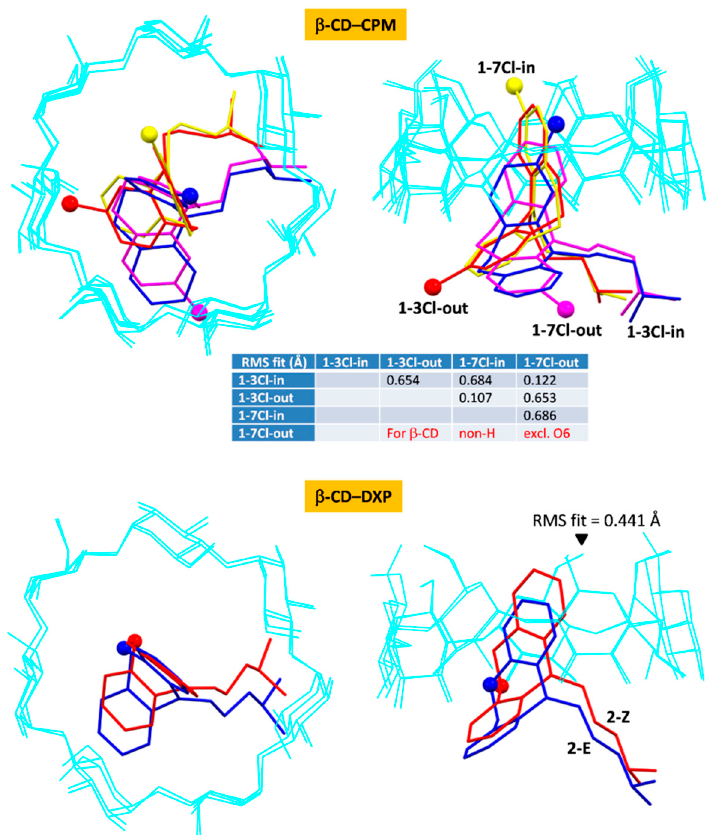
Figure 7. Superposition of molecular structures of β -CD–CPM (four modes) and β -CD–DXP (two modes) inclusion complexes from DFT full-geometry optimization; top view (left) and side view (right). Root mean square (RMS) fits are calculated for the host β -CDs (cyan wireframes), excluding O6, H atoms, and guest molecules; see also Figures 2 and S1 and Tables 2, 3 and S7.